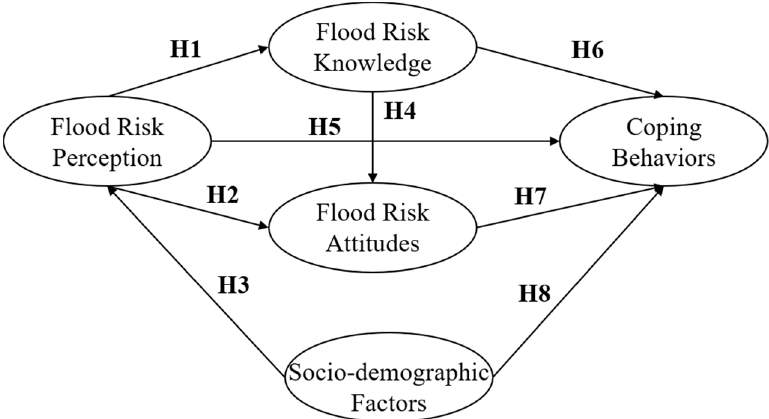
Figure 2. Path hypothesis of flood risk perception, flood risk knowledge, flood risk attitudes, protective coping behaviors, and socio-demographic